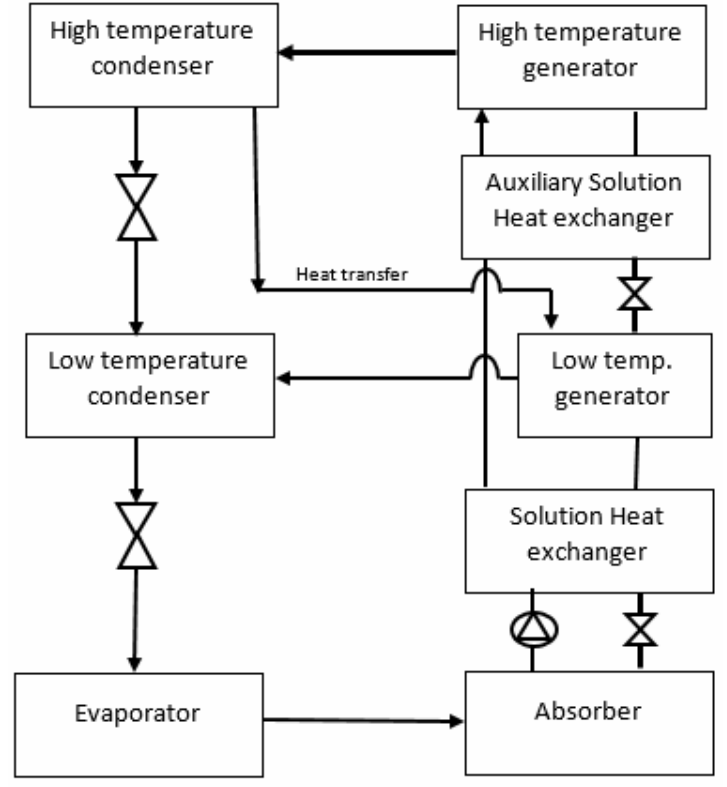
Figure 3. Double effect VAR system.